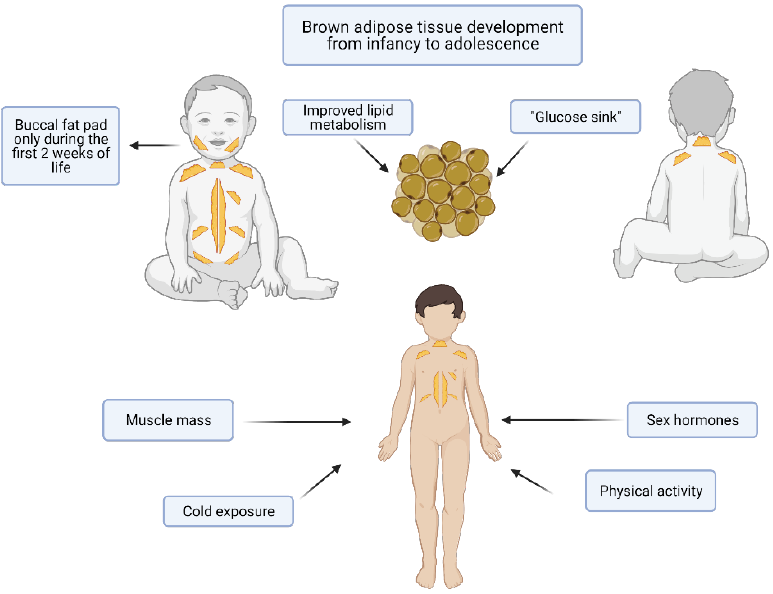
Figure 2. Brown adipose tissue (BAT) in infants and adolescents. The main sites of BAT accumulation in infants are the interscapular region (the one with the highest thermogenic activity), the neck, the axillae, areas around the trachea, the esophagus and the large vessels within the mediastinum and intraabdominally in the paravertebral and perinephric spaces. The buccal fat pad is composed of BAT in the first weeks of life. During puberty, there is both a substantial gain in muscle mass, mediated by sex hormones, cold exposure and physical activity. Made by © BioRender 2021.